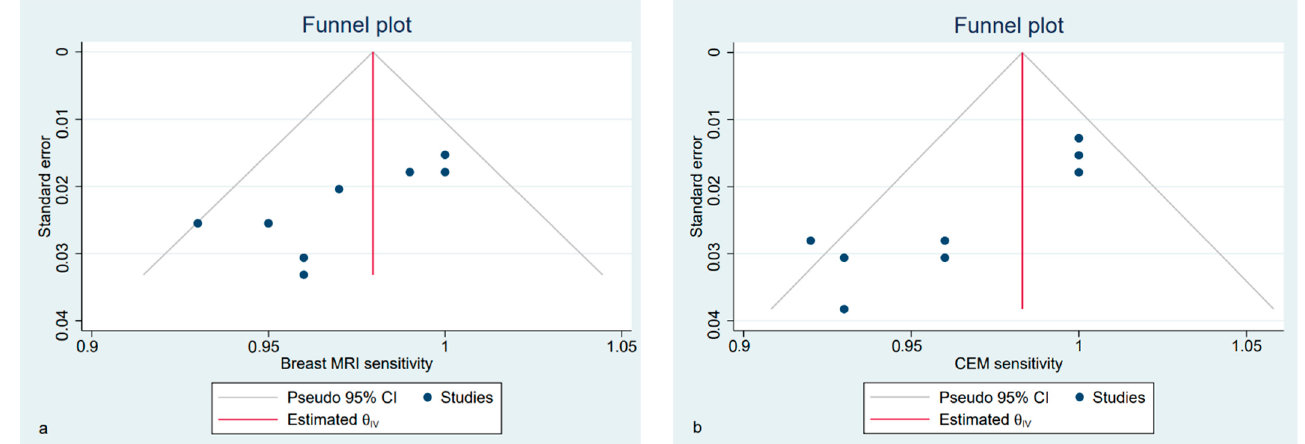
Figure 9. Funnel plot with 95% CIs for publication bias assessment for the pooled sensitivity of CE-MRI ( a ) and CEM ( b ) in preoperative staging.